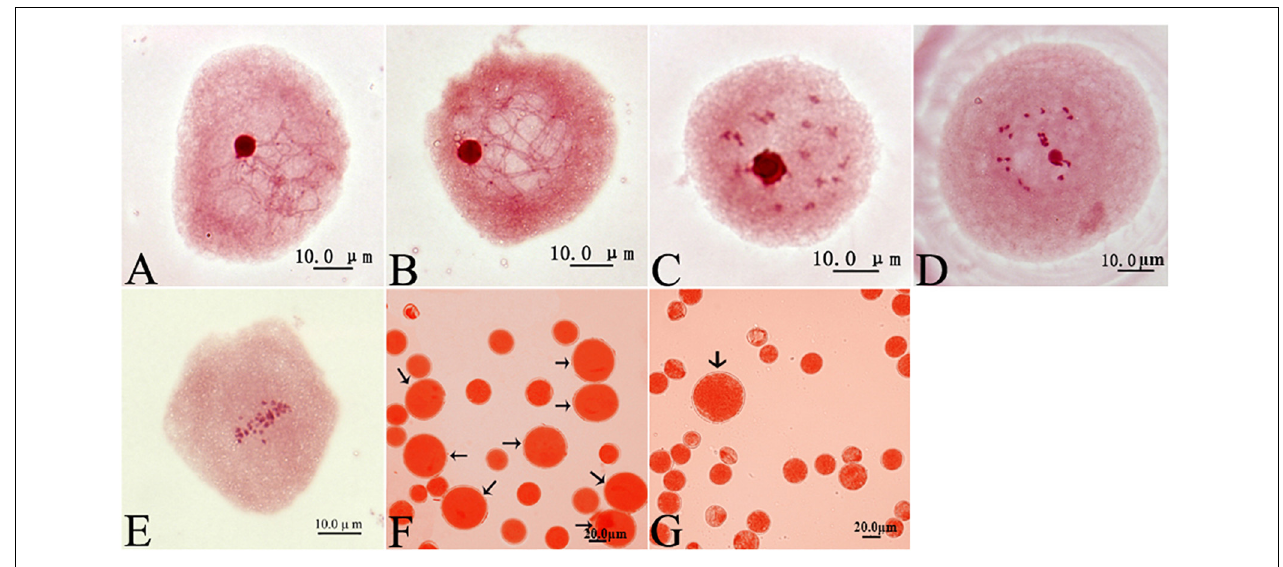
FIGURE 1 | Cytological observations of PMCs, colchicine-induced 2n pollen (arrow) and naturally occurring 2n pollen in Populus canescens . (A) Leptotene. (B) Pachytene. (C) Diplotene. (D) Diakinesis. (E) Metaphase I. (F) Colchicine-induced 2n pollen derived from the treatment given 11 injections at pachytene in P. canescens (arrow). (G) Natural 2n pollen derived from the control group in P. canescens (arrow). Scale bar = 10.0 µ m (A–E) and 20.0 µ m (F,G) .